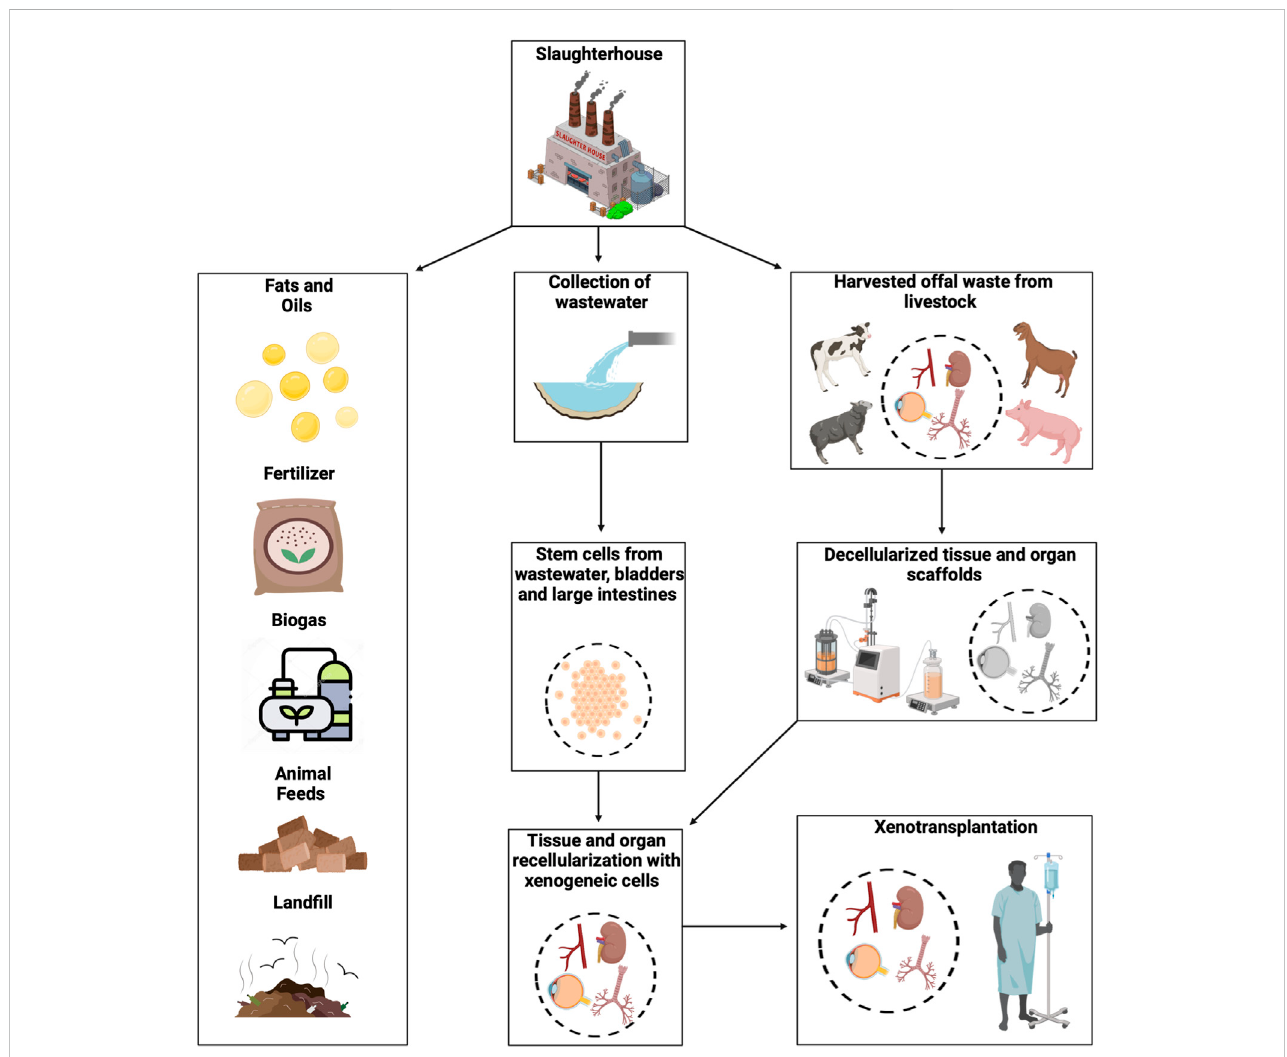
FIGURE 1 An overview of utilizing slaughterhouse waste for xenotransplantation. The image shows a pathway to harvest biological waste and wastewater from slaughterhousesthatcanbetransportedtoresearchfacilities.Theschematicalsooutlineswayssuchbiologicalwastehastraditionallybeenrepurposedasfats andoils,fertilizers,biogas,andanimalfeed.Besides,thewastethatisnotgenerallyrecycledissenttoland fi llsorcanbeusedtodevelopbioarti fi cialtissuesand organs. These discarded materials can then be processed into acellular templates, and stem cells may be extracted from the excreta to support the development of replacement tissues and organs and bioeconomic